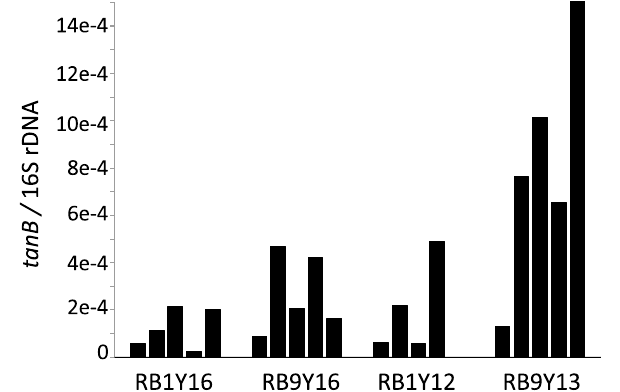
Figure 5. The ratios of tanB to16S rRNA genes copy numbers ( tanB/ 16S rDNA). Bars indicate the mean values of triplicate qPCR replicates from individual deer (n = 5/group), and error bars representing the standard deviation are shown but absent due to their small